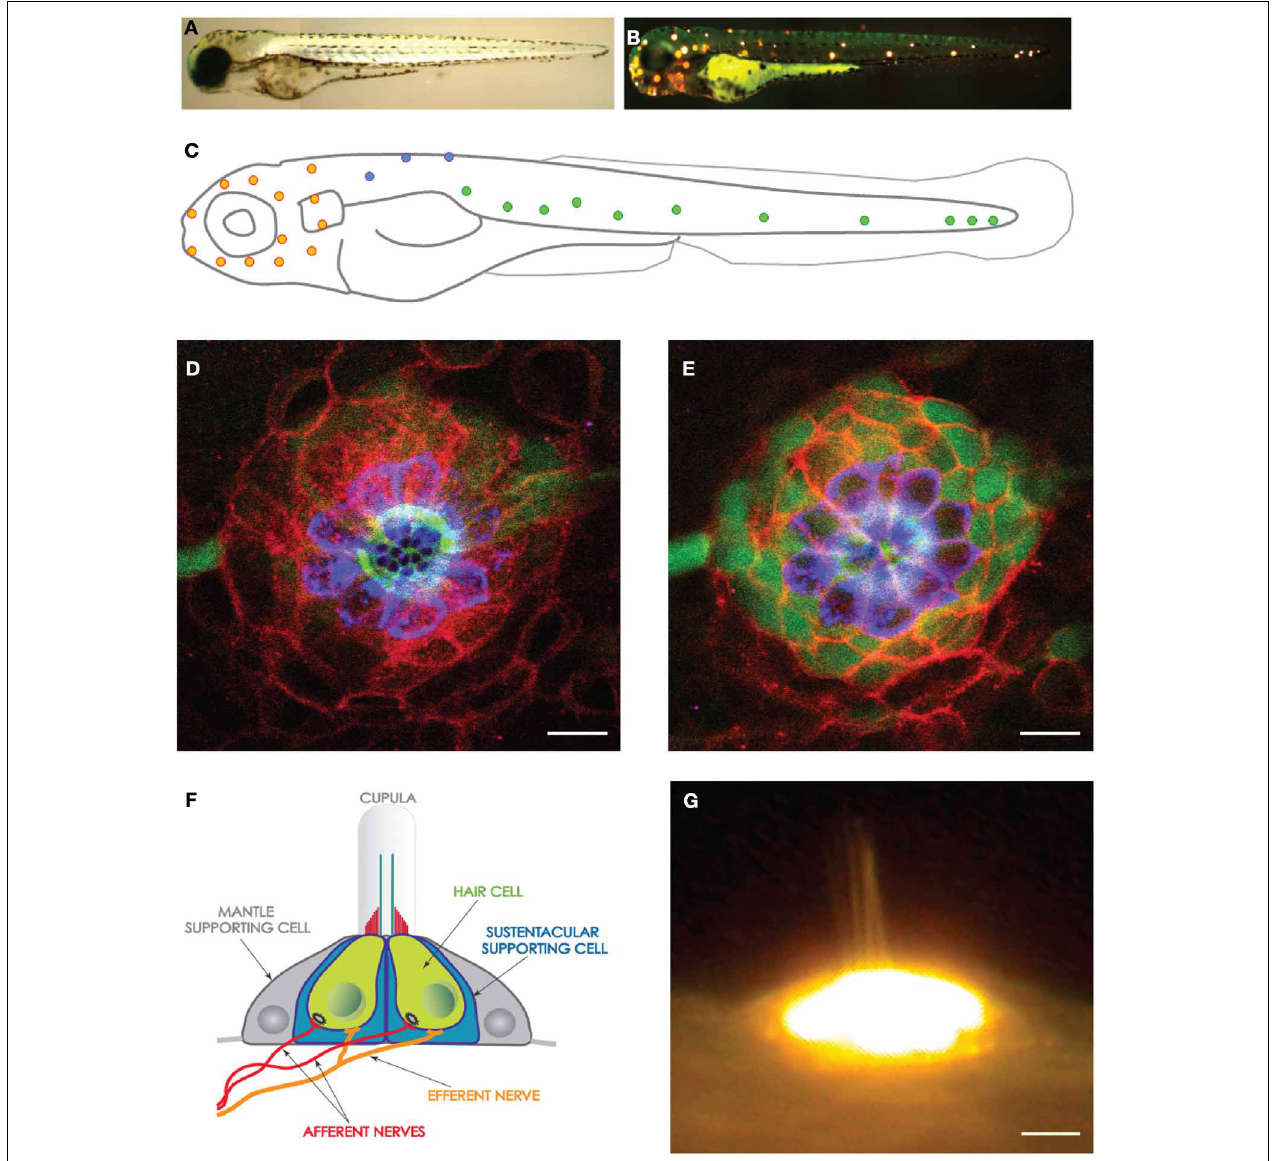
FIGURE 1 | The lateral line and neuromasts in the zebrafish larva. (A) Low magnification view of a zebrafish larva under transmitted light. (B) Hair cells in the lateral line were labeled with the fluorescent vital dye DiAsp (bright orange). It shows the superficial distribution of neuromasts along the anterior (head) and posterior (trunk and tail) lateral-line systems. (C) Schematic representation of the distribution of the neuromasts in the lateral line of a zebrafish larva. Orange highlights the anterior neuromasts,